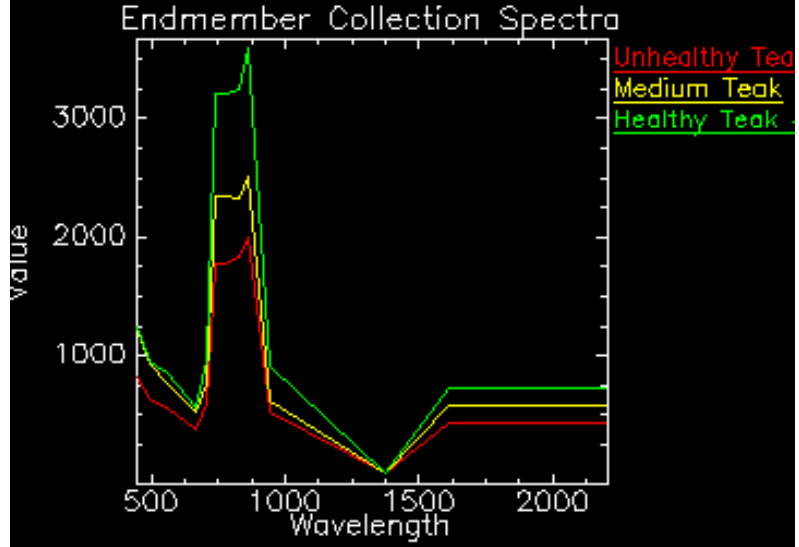
Figure 2. An average of spectra for Tectona grandis L. in 45 plots.